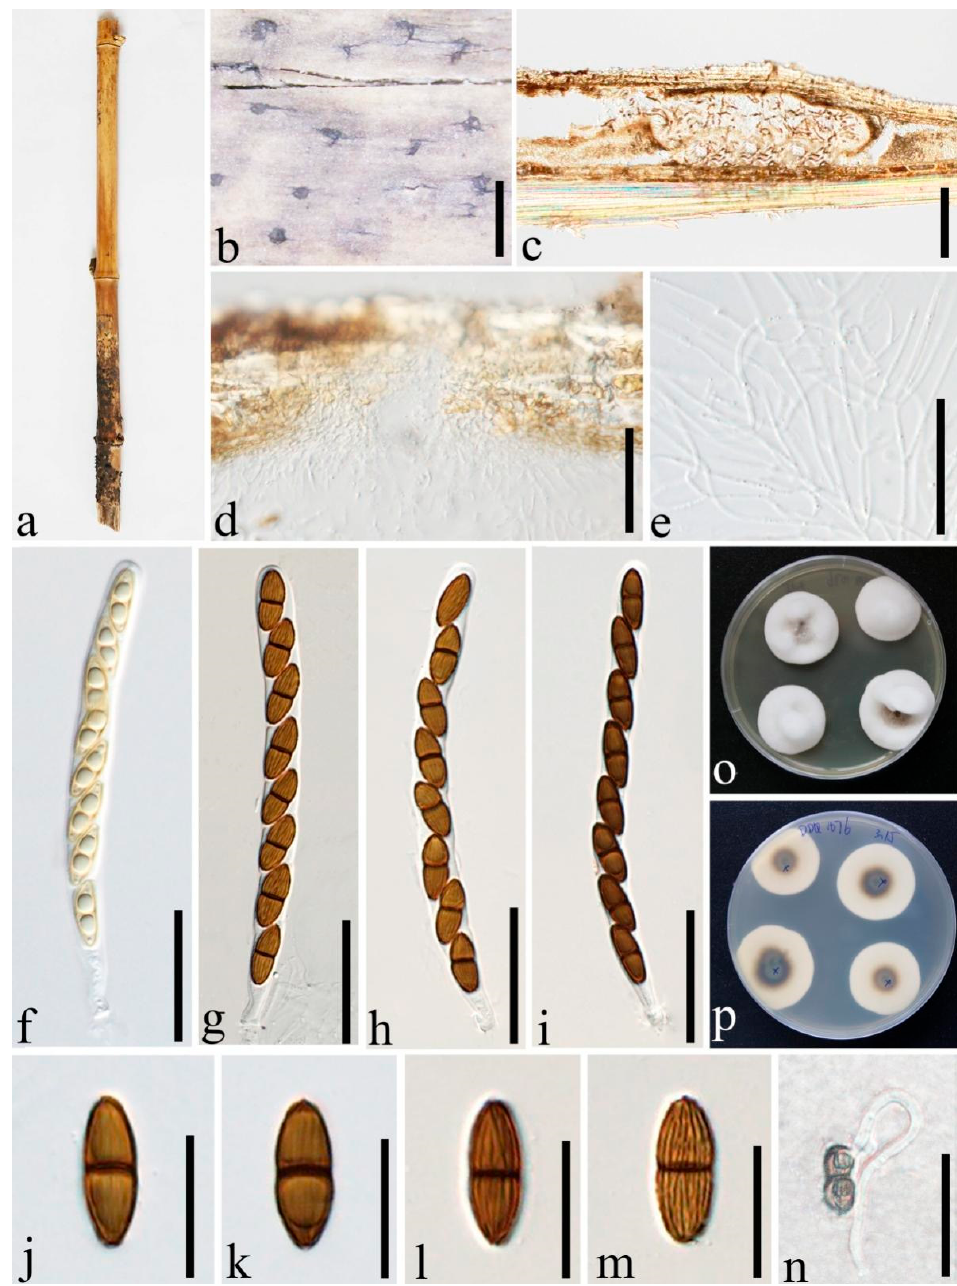
Figure 7. Roussoella papillate (GMB129, holotype). ( a ) Bamboo specimen; ( b ) black ascostromata on host surface; ( c ) vertical section of ascoma; ( d ) cells of locule wall near the ostiole; ( e ) branching pseudoparaphyses; ( f – i ) asci; ( j – m ) ascospores; ( n ) germinating ascospore; ( o , p ) cultures on PDA from above and below. Scale bars: ( b ) = 500 µ m, ( c ) = 150 µ m, ( d ) = 50 µ m, ( e – i , n ) = 30 µ m, ( j – m ) = 15 µ